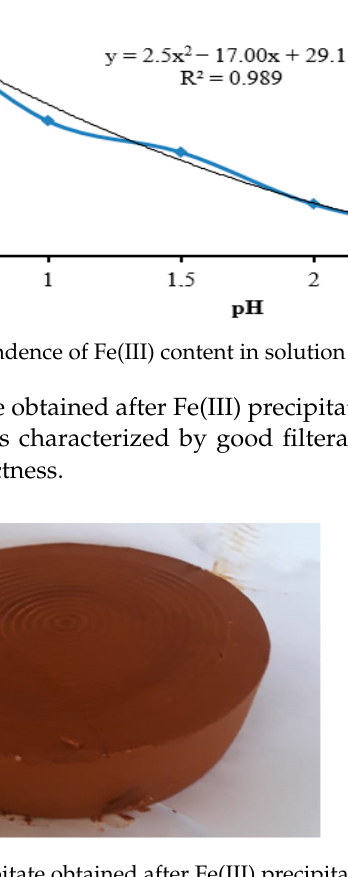
Figure 13. Precipitate obtained after Fe(III) precipitation from direct electrooxidation solutions.